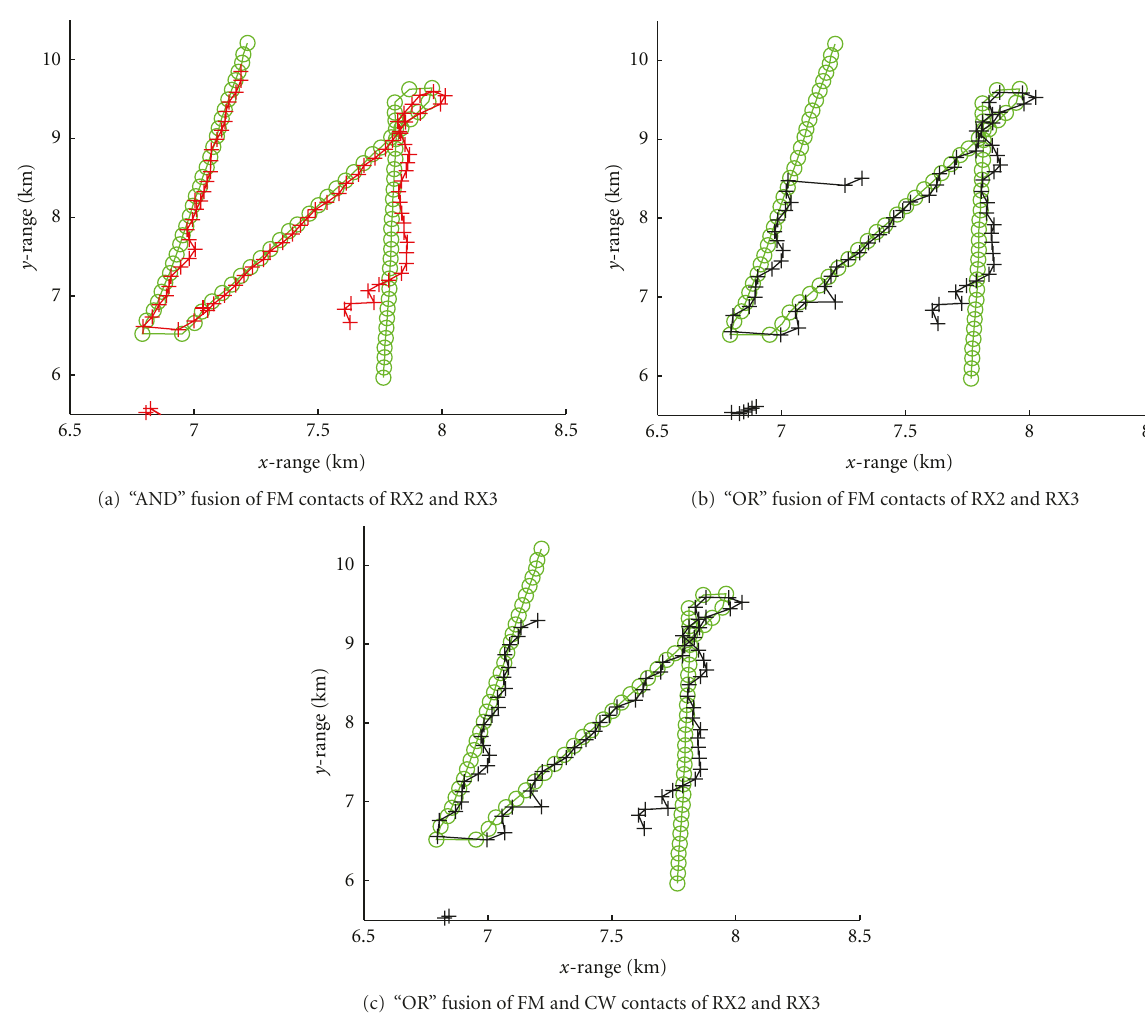
Figure 13: Tracking results using only FM contacts (a)-(b) and FM and CW contacts (c); target area is shown in detail; tracks are illustrated by plus signs versus the position of the towing ship (green